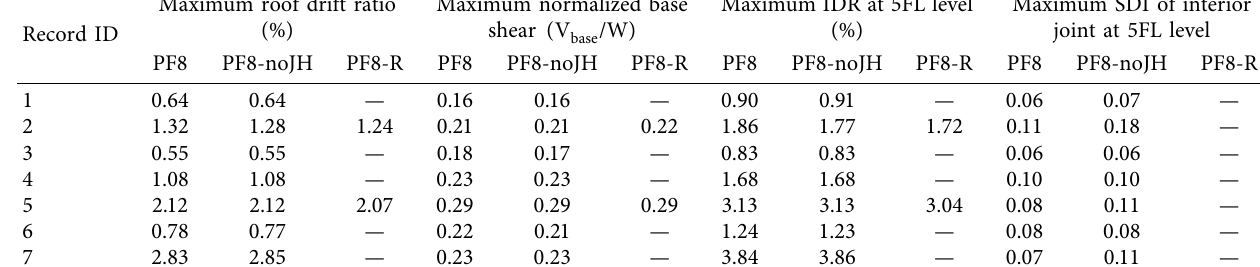
Table 4: Seismic demands placed upon the eight-story frames for the selected ground motions.